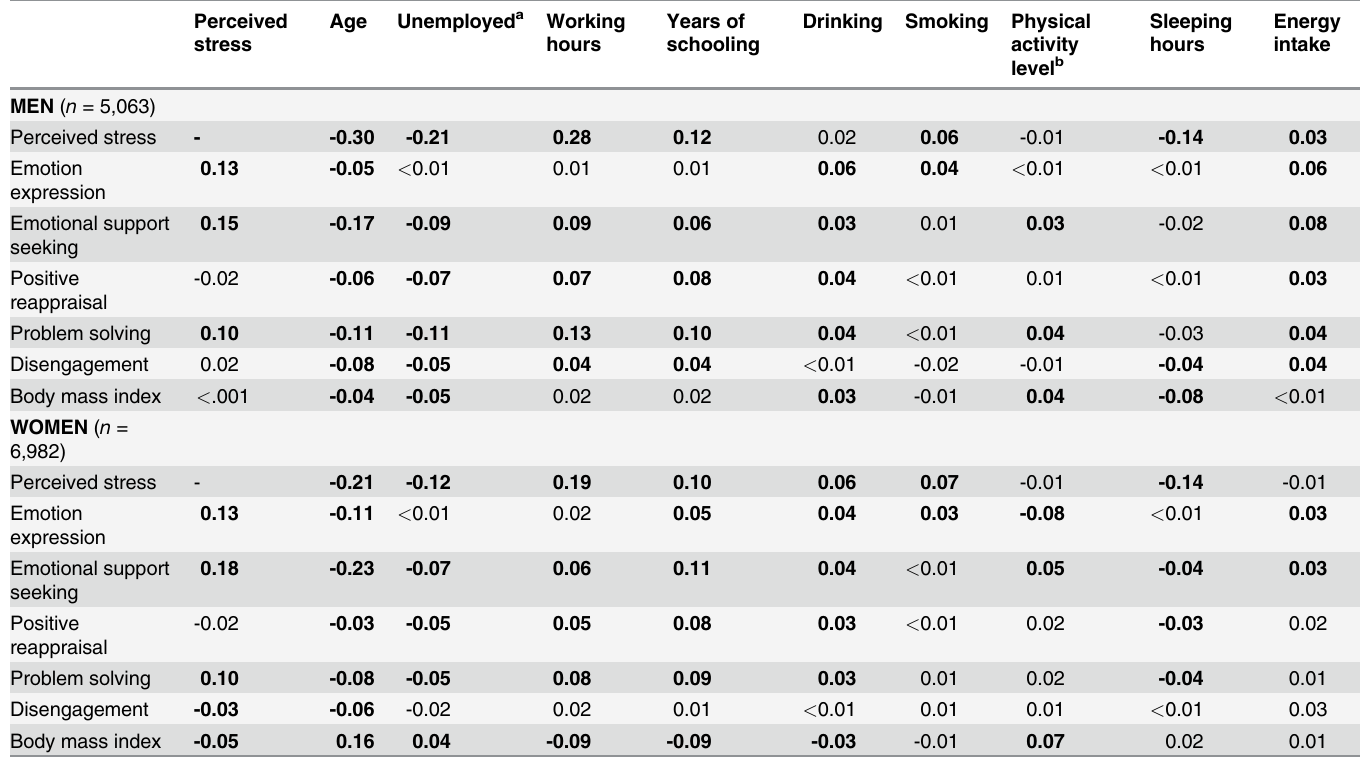
Table 2. Spearman ’ s rank correlation coef fi cients between psychosocial factors/body mass index and covariates by gender — Japan, 2005 – 2007. Perceived